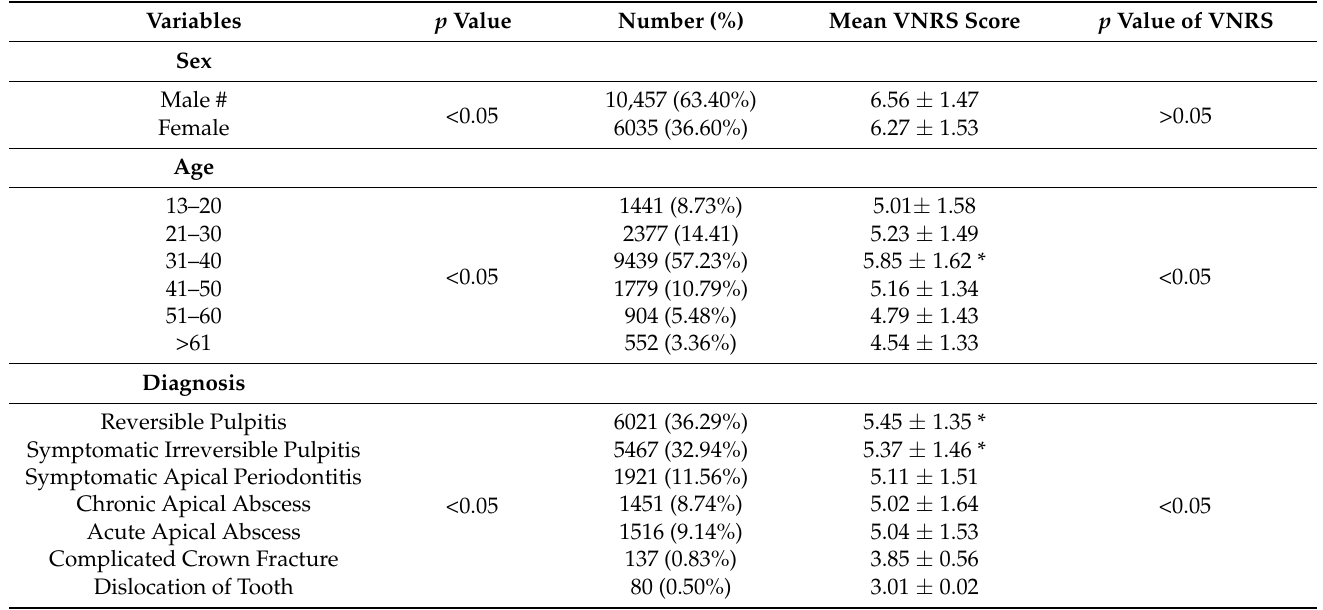
Table 3. The total number of patients with different sex, age, endodontic emergencies, and the mean VNRS for those who visited the dental school during both of the